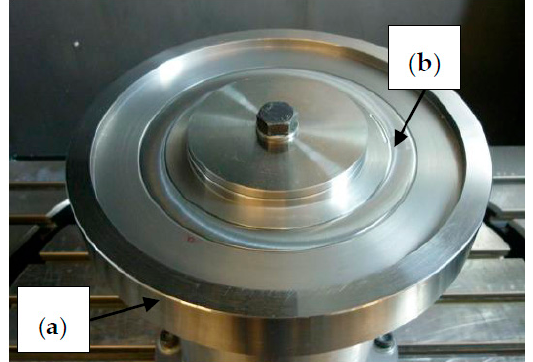
Figure 3. Test mounting of gear blank: ( a ) circular run reference surface; ( b ): axial run reference surface.